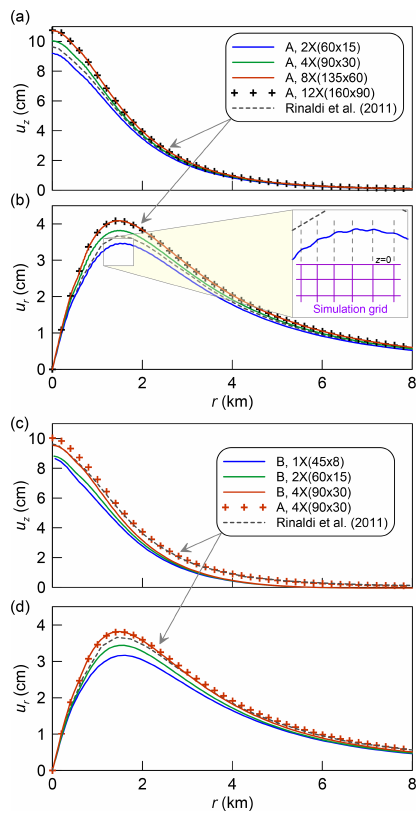
Figure 9. Displacements u z (a, c) and u r (b, d) at t = 20 months calculated using different methods and grids. The oscillatory be- haviour of u shown in (b) is caused by the space